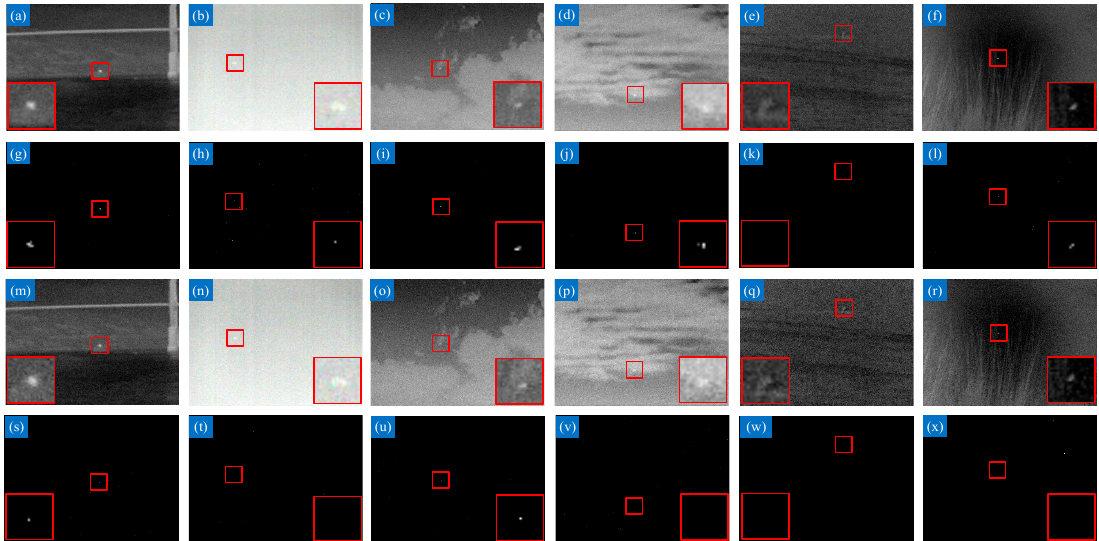
Figure A11. The first and third row show infrared images with additive white Gaussian noise with standard deviation of 10 and 20, and the second and fourth rows are the corresponding detection results by ReWIPI.